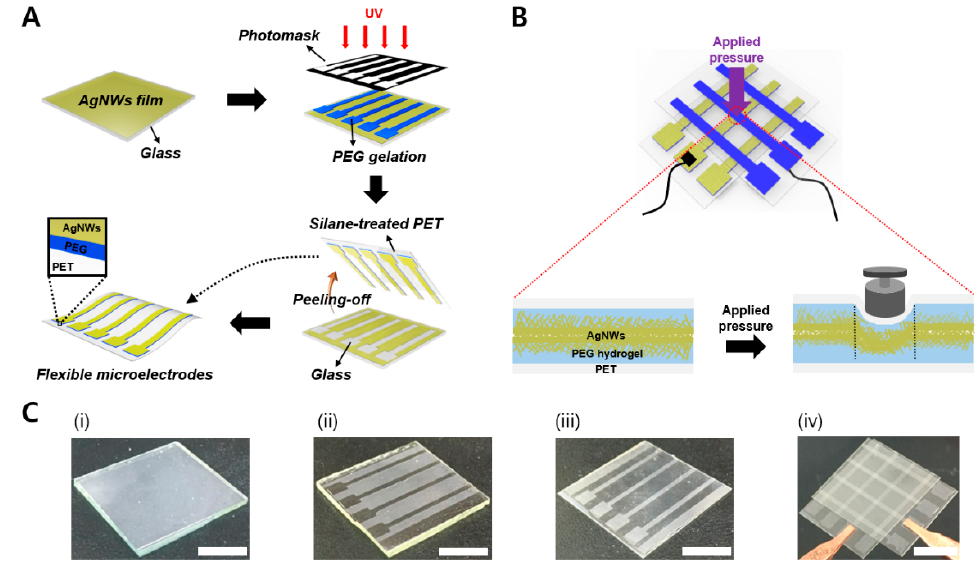
Figure 1. Schematic illustration of the fabrication of a resistive pressure sensor composed of elastic silver nanowires and poly(ethylene glycol) (AgNW-PEG) composite hydrogel patterned on flexible polyethylene terephthalate (PET). ( A ) Fabrication of flexible AgNW-PEG patterns on PET substrate via PEG photolithography. ( B ) Schematic illustration of the structural elasticity of the AgNW-PEG sandwich structure in the resistive pressure sensor. ( C ) Photographs of (i) AgNW film on glass, (ii) AgNWs left on glass after PEG photolithography, (iii) AgNW-PEG composite patterns on PET substrate, and (iv) resistive pressure sensor device based on AgNW-PEG sandwich structure (1 mm line pattern width; scale bars: 1 cm).